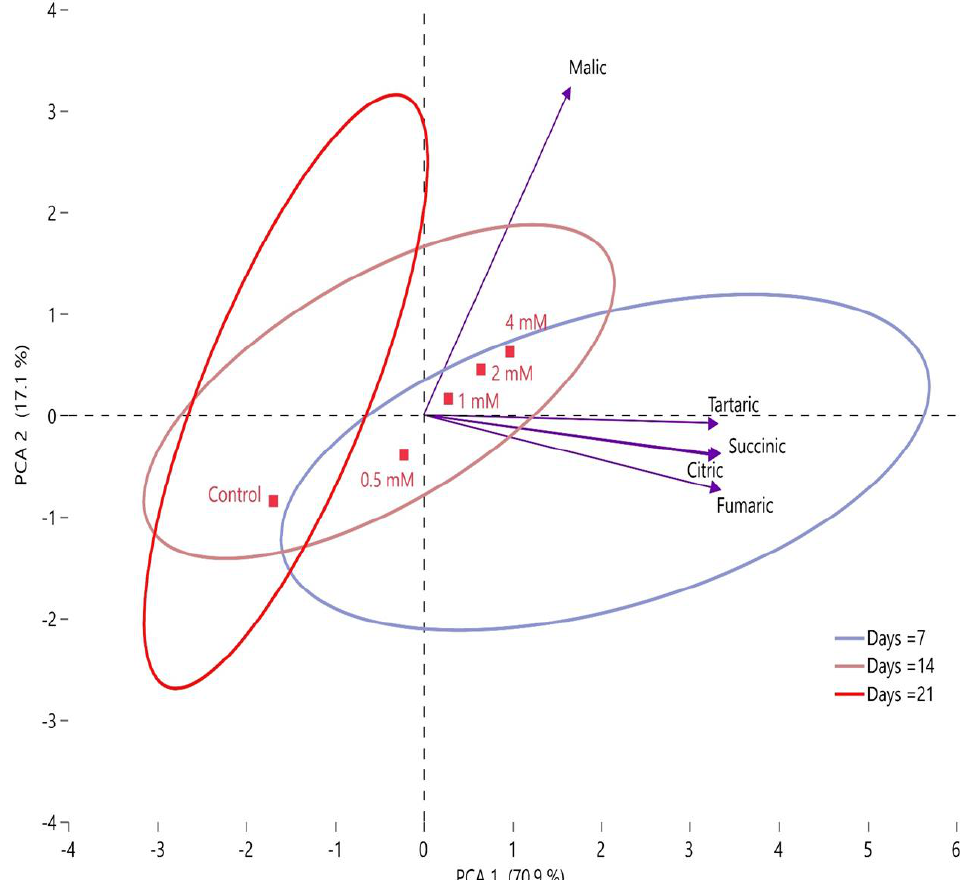
Figure 10. Determination of the effects of putrescine doses (control, 0.5 mM, 1 mM, 2 mM, and 4 mM) on organic acid contents during storage by PCA.